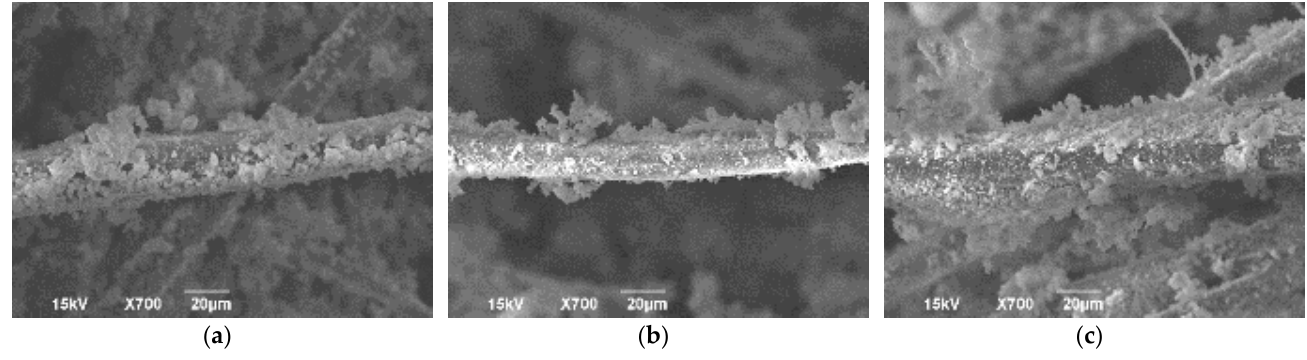
Figure 13. Nanosilica adherence to individual fibers. ( a ) 30% STF flax, ( b ) 50% STF flax, ( c ) 70% STF